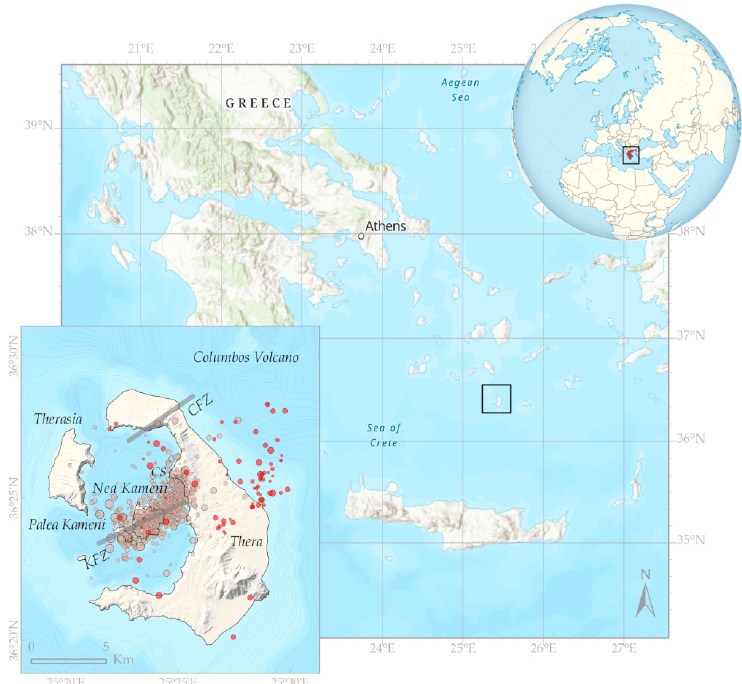
Figure 1. Location map of Santorini volcano and seismicity distribution for the period 2011–17 [2]. Earthquake foci in gray color represent the unrest period between January 2011 and May 2012 (ML ≤ 3.3), whereas epicenters in red correspond to the post-unrest period from September 2012 to August 2017 (ML ≤ 2.3). KFZ and CFZ represent the Kameni and Columbos Fault Zones, respectively. CS indicates Cape Skaros undergoing the maximum uplift (14 cm) during the 2011–12 unrest episode [4].